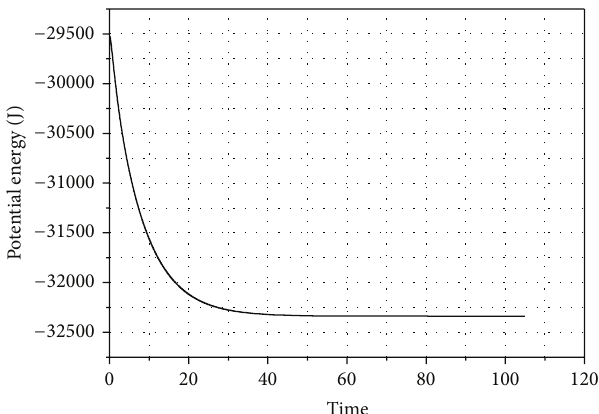
Figure 9: Potential energy of the 50-link chain.